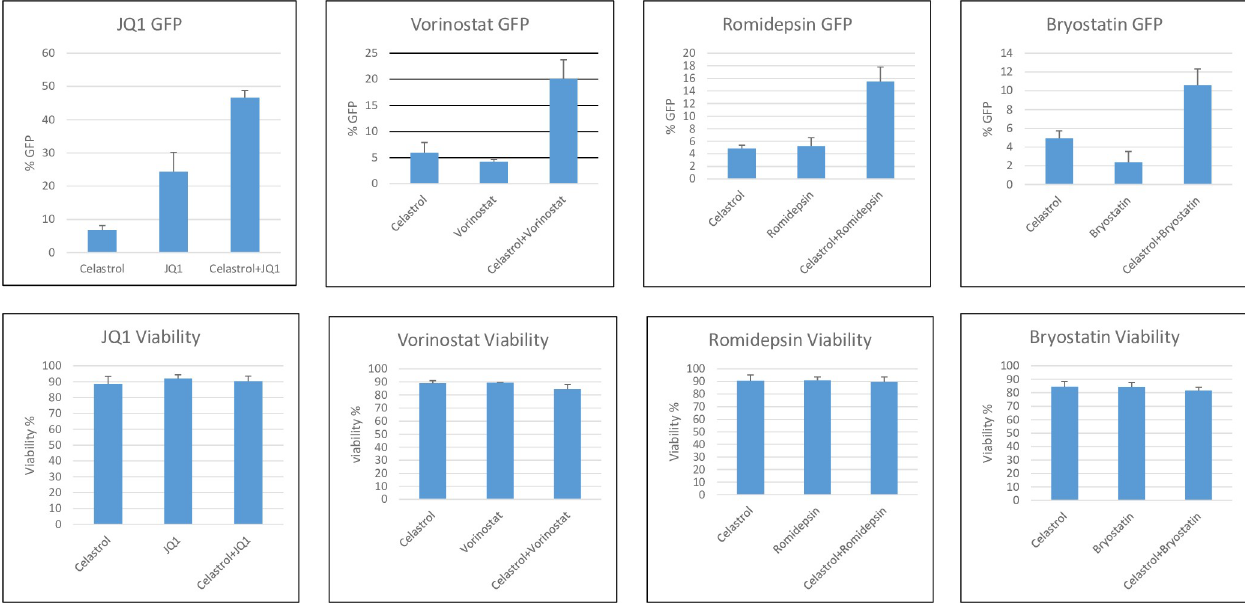
Fig 2. Reactivation of latent HIV-1 with combinations of celastrol and well-characterized LRAs. Jurkat 2D10 cells were treated with 0.4 μ M celastrol plus 0.2 μ M JQ1, 400 nM vorinostat, 20 nM romidepsin, or 0.2 ng/ml bryostatin. Reactivation of latent HIV-1 was quantified by flow cytometry analysis of eGFP expression at 24 hours post-treatment. Cell viability was quantified by Vi-Cell (Beckman Coulter). Bliss synergy scores for 0.4 μ M celastrol plus JQ1 (0.2 μ M), Bryostatin (0.2 ng/ml), Vorinostat (0.4 μ M), or Romidepsin (20 nM) were 13.2, 8.4, 19.9, and 13.8, respectively. The data presented in Fig 2 are representative of more than three biological replicate